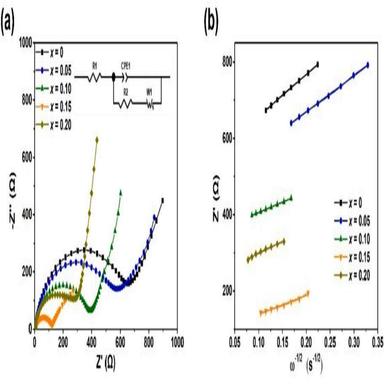
(a) Nyquist diagram of Na3V2-xFex(PO4)2O2F (x = 0, 0.05, 0.10, 0.15, 0.20) before cycling in the frequency range of 0.01 Hz to 100 kHz (insert equivalent circuit); (b) Z' and ω-1/2 in the low-frequency range relationship.